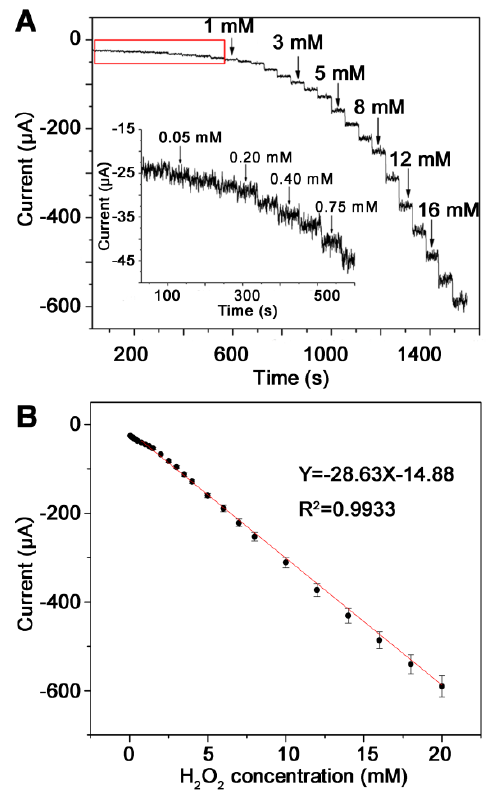
Figure 5. Kinetics of MoS 2 -Au-Ag/GCE. ( A ) The i-t curve of the MoS 2 -Au-Ag/GCE when different concentrations of H 2 O 2 were added to the PBS buffer successively. ( B ) Linear fitting diagram.